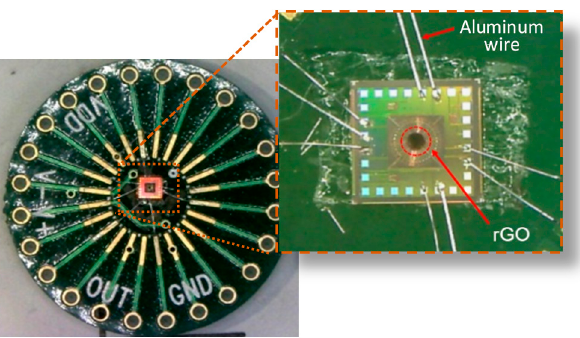
Figure 6. The measured circuit board with the CMOS-MEMS thermopile.